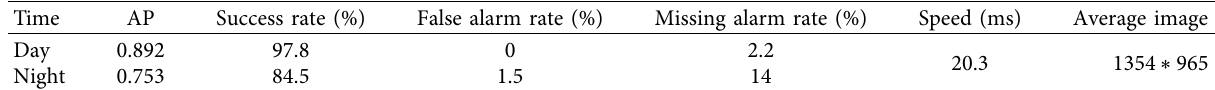
Table 2: Daytime and nighttime detection results.